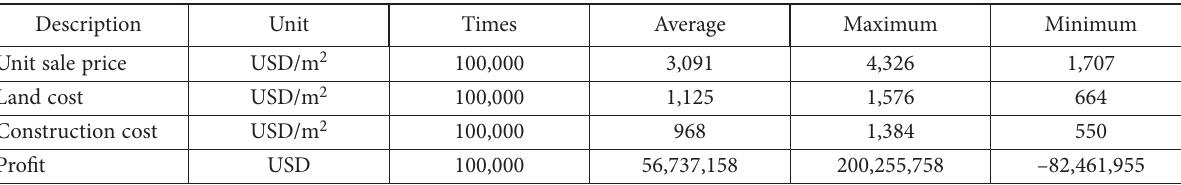
Figure 11. Random variable generation by factors and changes in project profit Table 3. Results of simulation at the initial project review